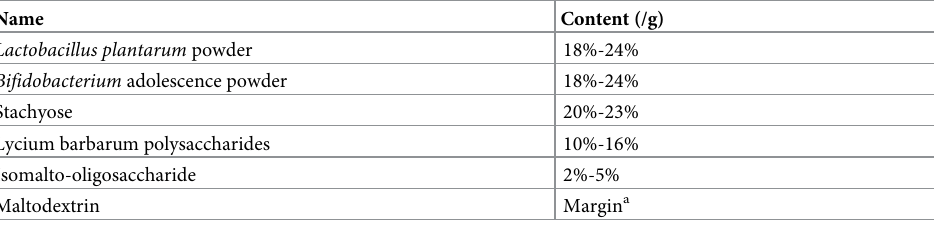
Table 1. Composition of the probiotic